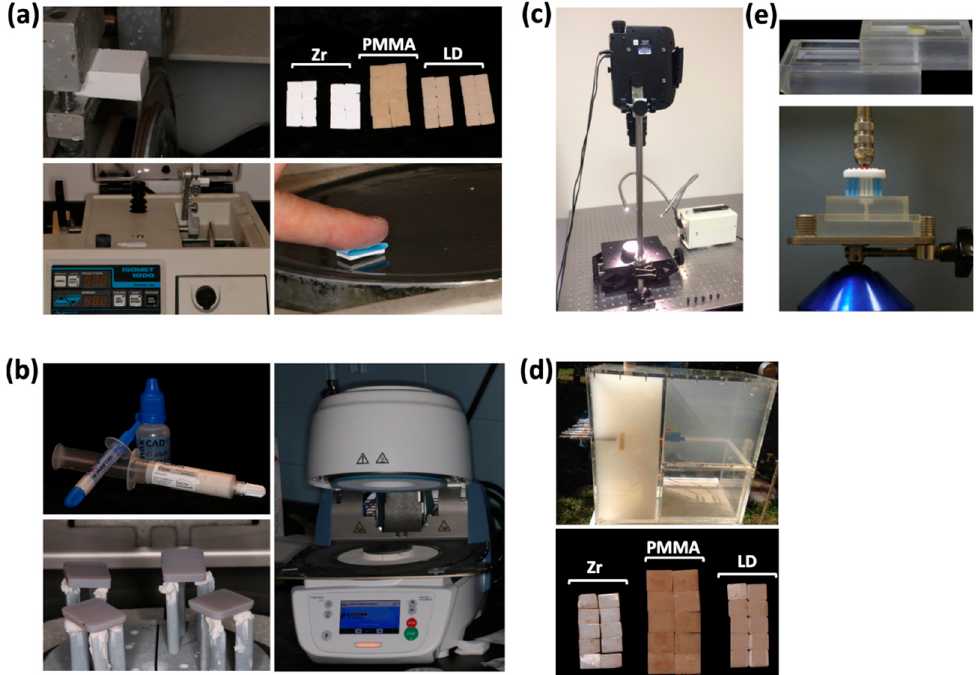
Figure 1. ( a ) Specimen preparation with sectioning and polishing; ( b ) specimen glazing and crystallizing; ( c ) spectroradiometer analysis; ( d ) smoking chamber used in the study and specimens after smoking exposure; ( e ) standardized sliding device for brushing and toothbrush head fixed on the paralellometer (reprinted with permission from Elsevier (License Number: 5392551271768)). Used acronyms: LD—lithium disilicate CAD, Zr—zirconia, PMMA—and Telio PMMA CAD.